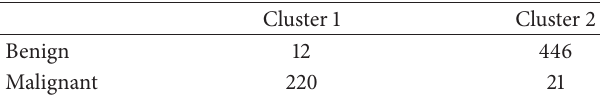
Table 6: Confusion matrix for the average clustering result with Ahmad and Dey [22] distance measure, for 𝑚 = 1.5 .